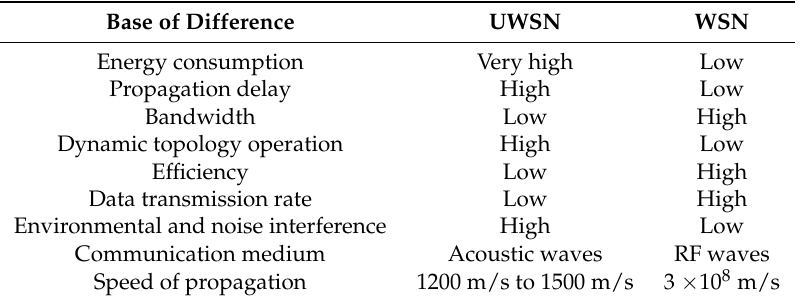
Table 1. Basic differences between UWSN and